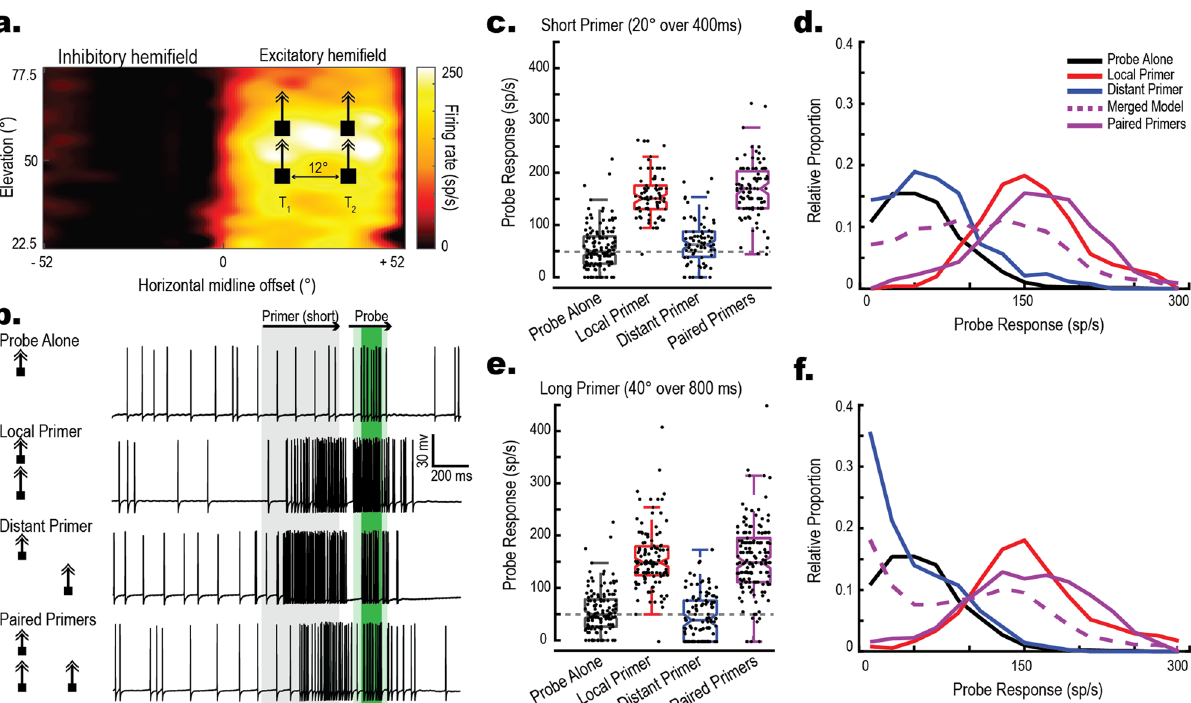
Fig. 1 Paired targets generate facilitated responses. a CSTMD1 ’ s Receptive Field with schematic stimulus pictogram superimposed (not to scale). The receptive fi eld was mapped with a single 2°x 2° target moving horizontally (left-to-right) at 80°/s. The receptive fi eld consists of two distinct zones, the excitatory hemi fi eld (contralateral to the recording site in the axon) and the inhibitory hemi fi eld (ipsilateral to the recording site.) b Left; Stimulus pictograms of four trial conditions (T 1 Probe locations shown; the same trials were also run using a T 2 Probe, i.e. mirrored). Top to bottom: Probe Alone, a 200 ms target Probe is presented alone. Local Primer, a Probe is spatiotemporally preceded by a facilitatory Primer on a matched trajectory. Distant Primer, the same Probe is preceded by a Primer on an unmatched trajectory (12° horizontal offset). Paired Primers, the same Probe is preceded by both a Local and Distant primer simultaneously. Right; Example spike trains drawn from the same neuron. Light green box indicates the 200 ms Probe period. Dark green box indicates the 100 ms analysis window. c , d Results for the presentation of Short Primers lasting 400 ms. c Box-and-whisker plots with overlaid swarm plots showing Probe response to the varying conditions. Each dot represents an individual trial (389 total trials across 15 dragon fl ies). Spike rate was calculated from a 100 ms period 50 ms following the onset of the probe ( b , dark green window). d Frequency polygons of the same data. Merged Model (purple, dashed) represents the combined Local (red) and Distant (blue) Primer distributions. The empirical Paired Primer distribution (purple, solid) more closely matches Local Primer condition than a combination of local and distant primers, indicating overall facilitation. e , f The experiment with Long Primers (800 ms) exhibits similar results (507 total trials across 15 dragon fl ies), presented as in c , d . Note Probe Alone data is repeated from c